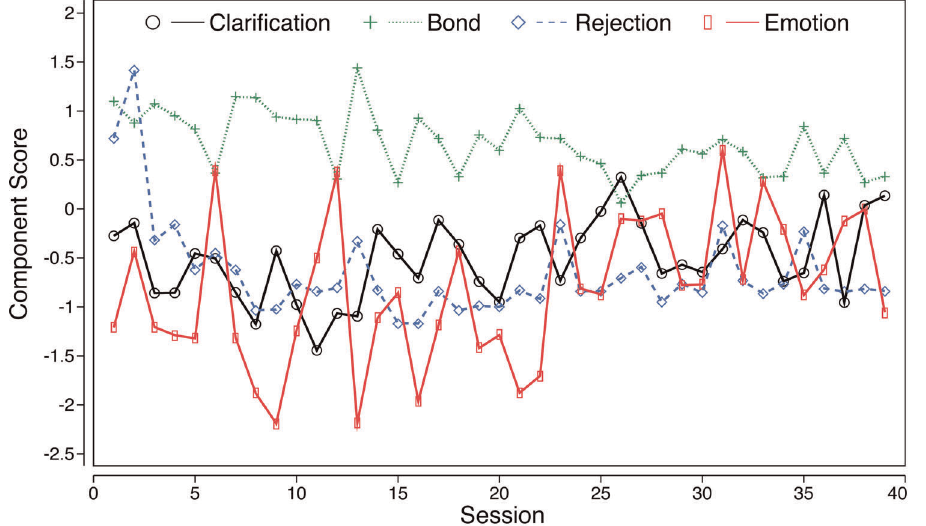
Figure 1. Exemplary time series. Time series of patient # 124 (57 y, male, diagnosed as having narcissistic PD). Abscissa, subsequent sessions; Ordinate, values of components Clarification, Bond, Rejection, and Emotional Activation